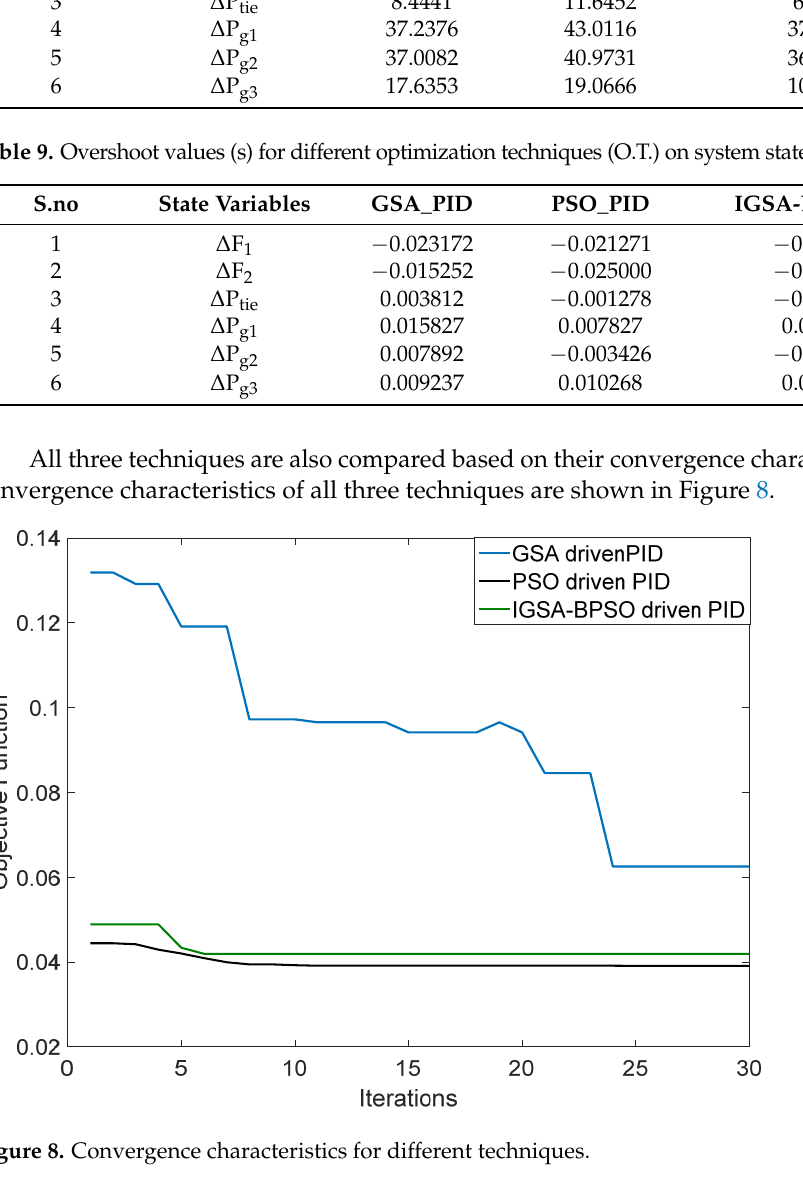
Table 8. Settling time values (s) for different optimization techniques (O.T.)–CVT.